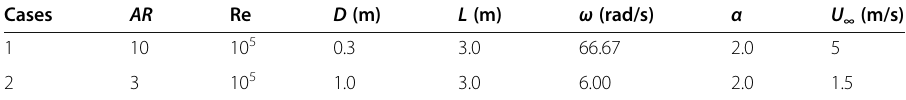
Table 1 Computational parameters of the single spinning cylinder